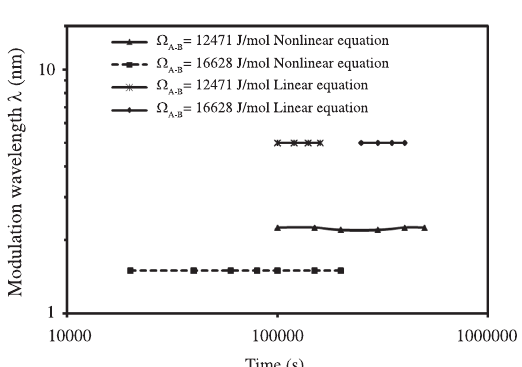
Figure 14. Plots of modulation wavelength λ vs. time t for linear and nonlinear equations for Ω values of 12471 and 16628 J/mol. A-B